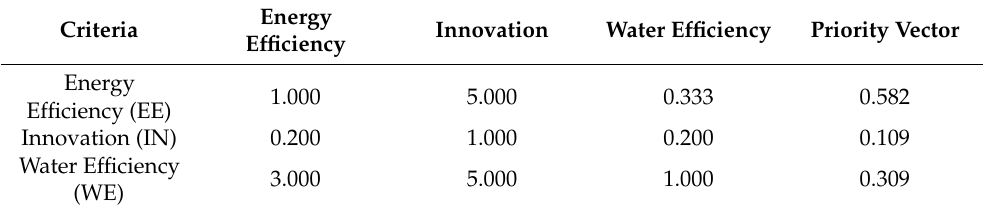
Table 5. Pairwise comparison matrix for the first level.